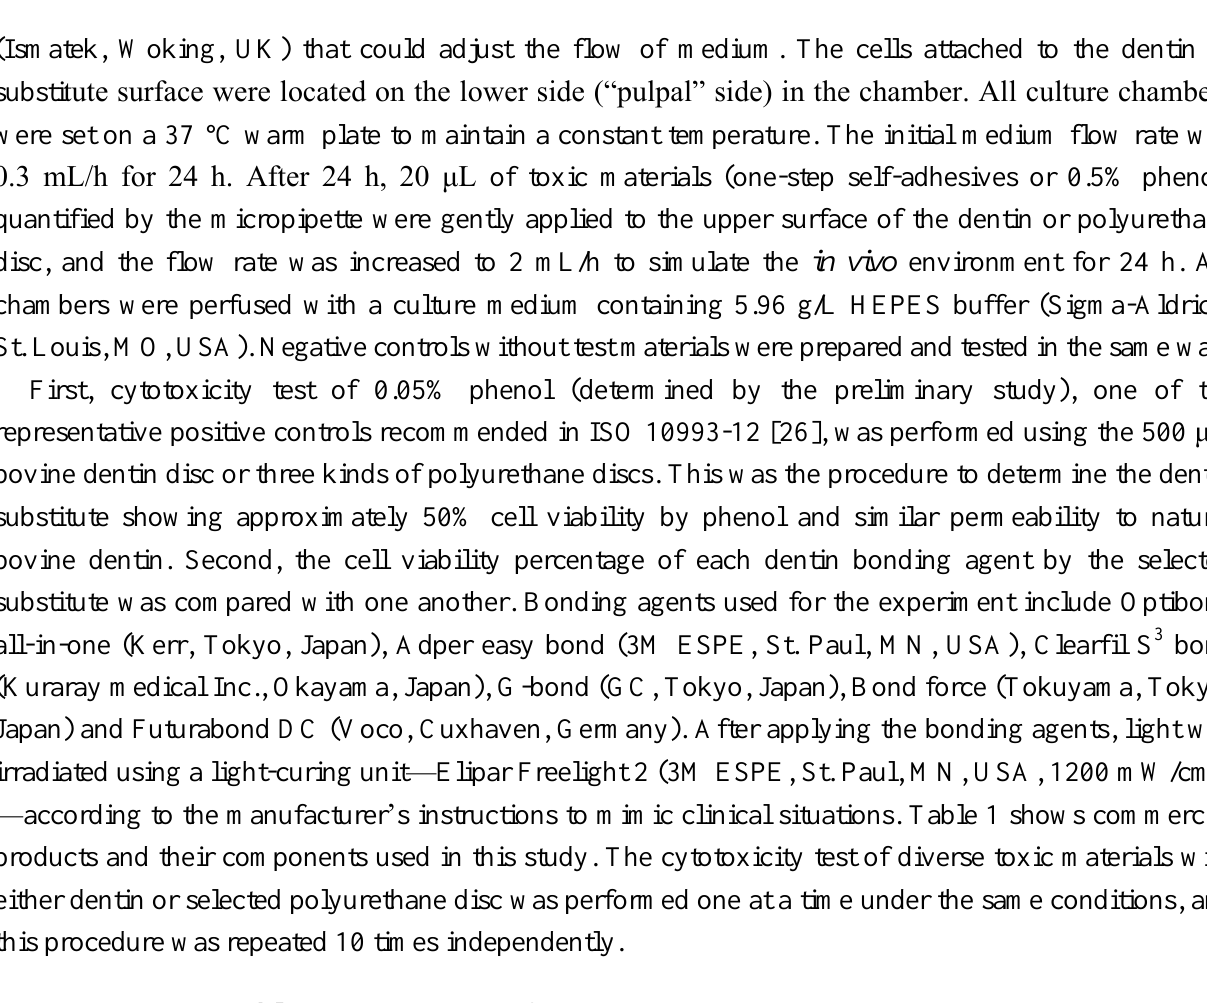
Table 1. Commercial self-etch adhesives and their